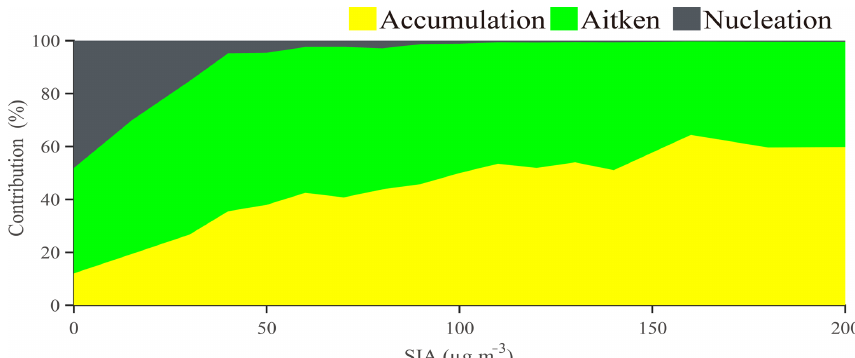
Figure 10. Variation of number concentration fraction of particles with SIA in Beijing during the whole study